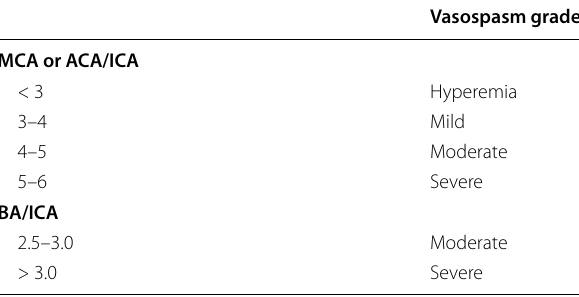
Table 1 The vasospasm grade is related to the two indexes, Lindegaard and